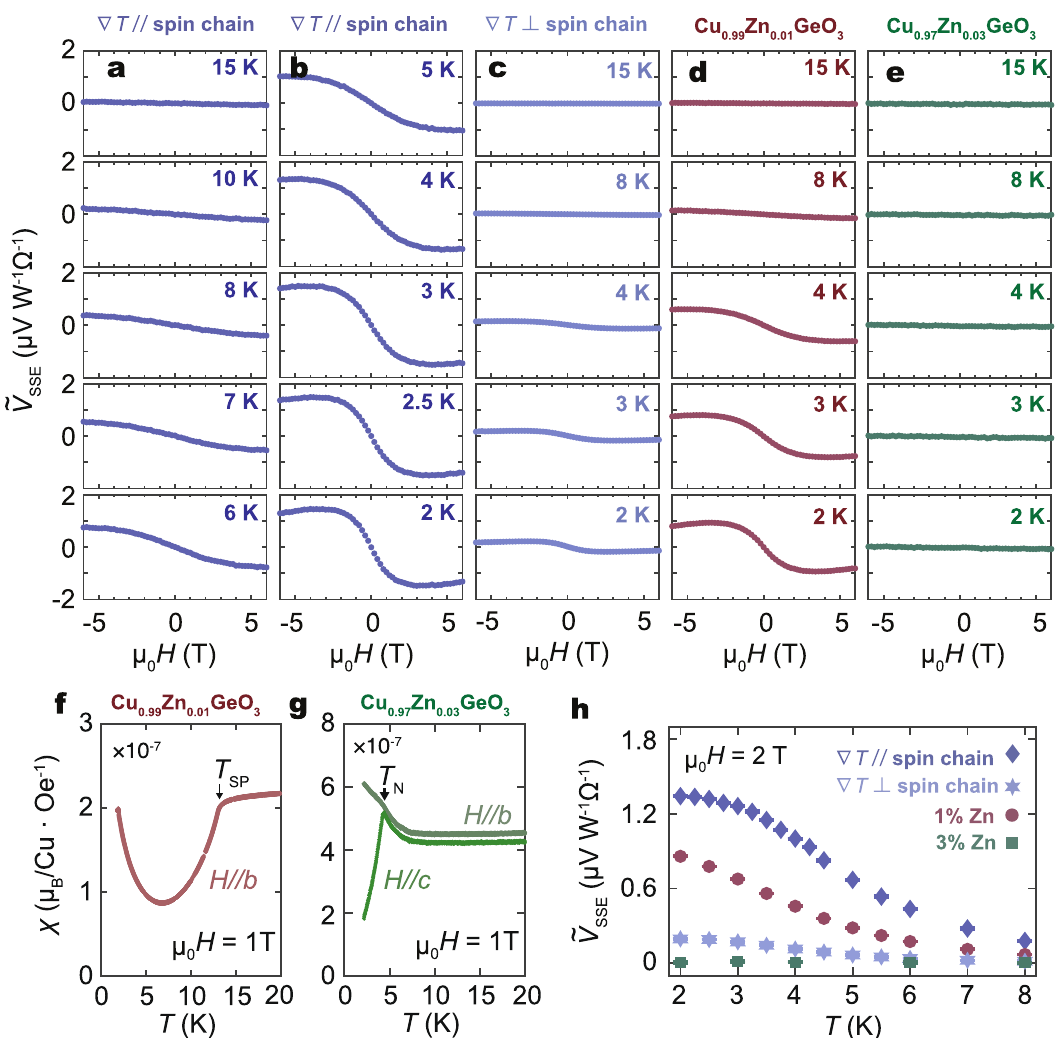
Fig. 3 Temperature dependence of SSE signal. a , b Magnetic fi eld ( H ) dependence of ~ V SSE (the SSE signal normalized to the heating power and the detector resistance) at selected temperatures ( T ) for CuGeO 3 /Pt, with temperature gradient ( ∇ T ) applied along the spin chain. c H dependence of ~ V CuGeO 3 /Pt, with ∇ T applied perpendicular to the spin chain. d , e H dependence of ~ V SSE at selected temperatures for Cu 0.99 Zn 0.01 GeO 3 /Pt and Cu 0.97 Zn 0.03 GeO 3 /Pt, respectively. In a – e , the SSE signal is normalized by the heating power and the detector resistance. f , g T dependence of magnetic susceptibility for Cu 0.99 Zn 0.01 GeO 3 and Cu 0.97 Zn 0.03 GeO 3 , respectively. h T dependence of SSE signal in different samples at μ 0 H = 2 T. Error bars represent standard